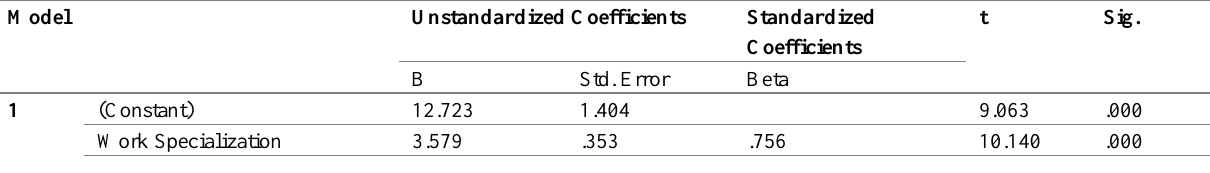
Table 8: Coefficient